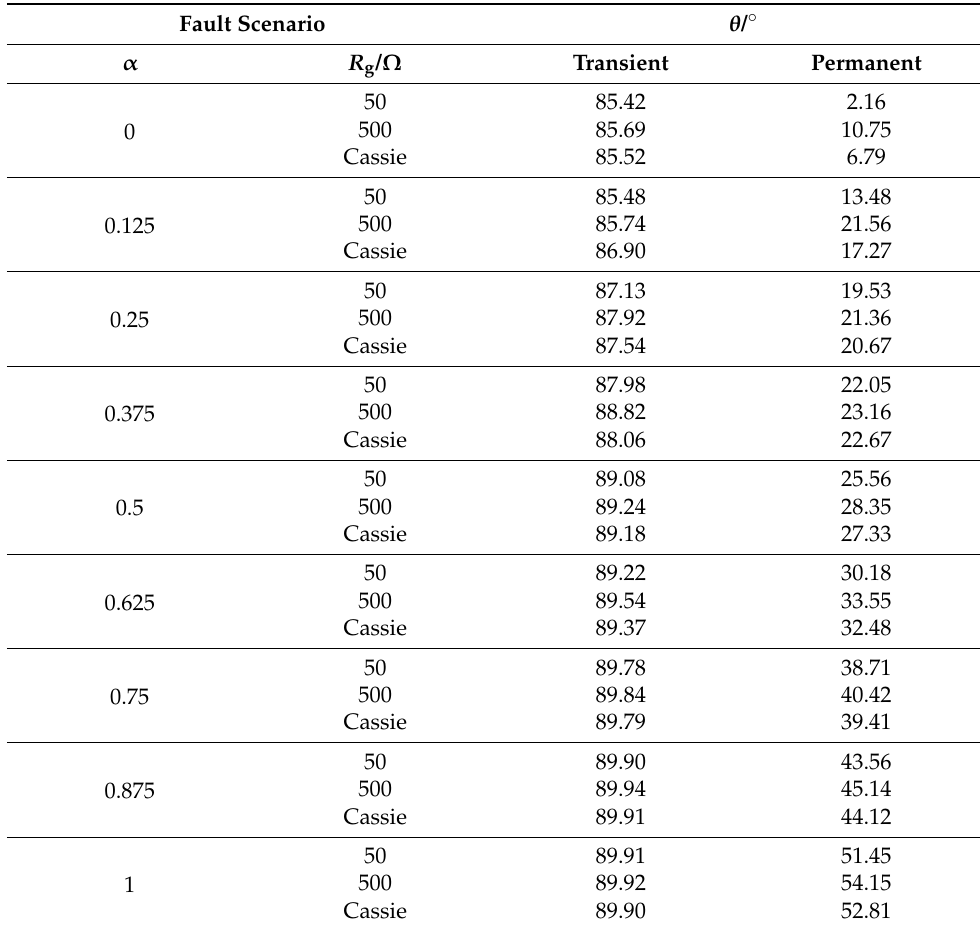
Table 5. Fault-type identification results under different fault